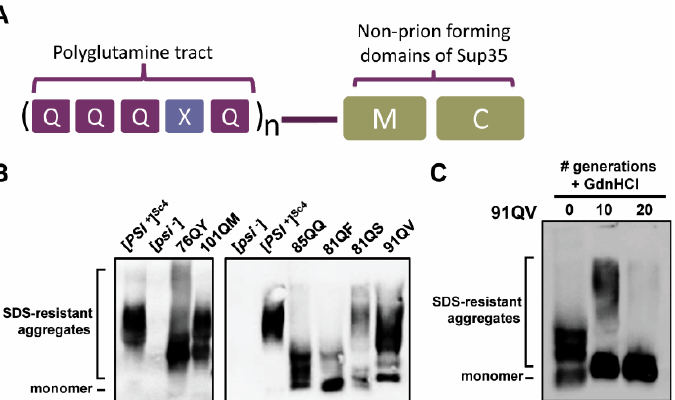
Figure 1. PolyQX-Sup35MC chimeras form stable Hsp104-dependent synthetic prions in yeast. ( A ) Gene structure diagrams of polyQX expression constructs. An N-terminal polyQ domain with a single residue interspersed every 5th residue is fused to the M and C domains of Sup35 as described in Alexandrov et al. [41]. In text and figures, constructs are denoted as in Alexandrov et al. by the overall length of the QQQXQ repeat region which sometimes ends with an additional terminal Q, followed by the letter Q and single letter code for the heterologous residue, e.g., 101QM. ( B ) PolyQX proteins form stable prions with detergent-resistant aggregates detectable by semi-denaturing detergent agarose